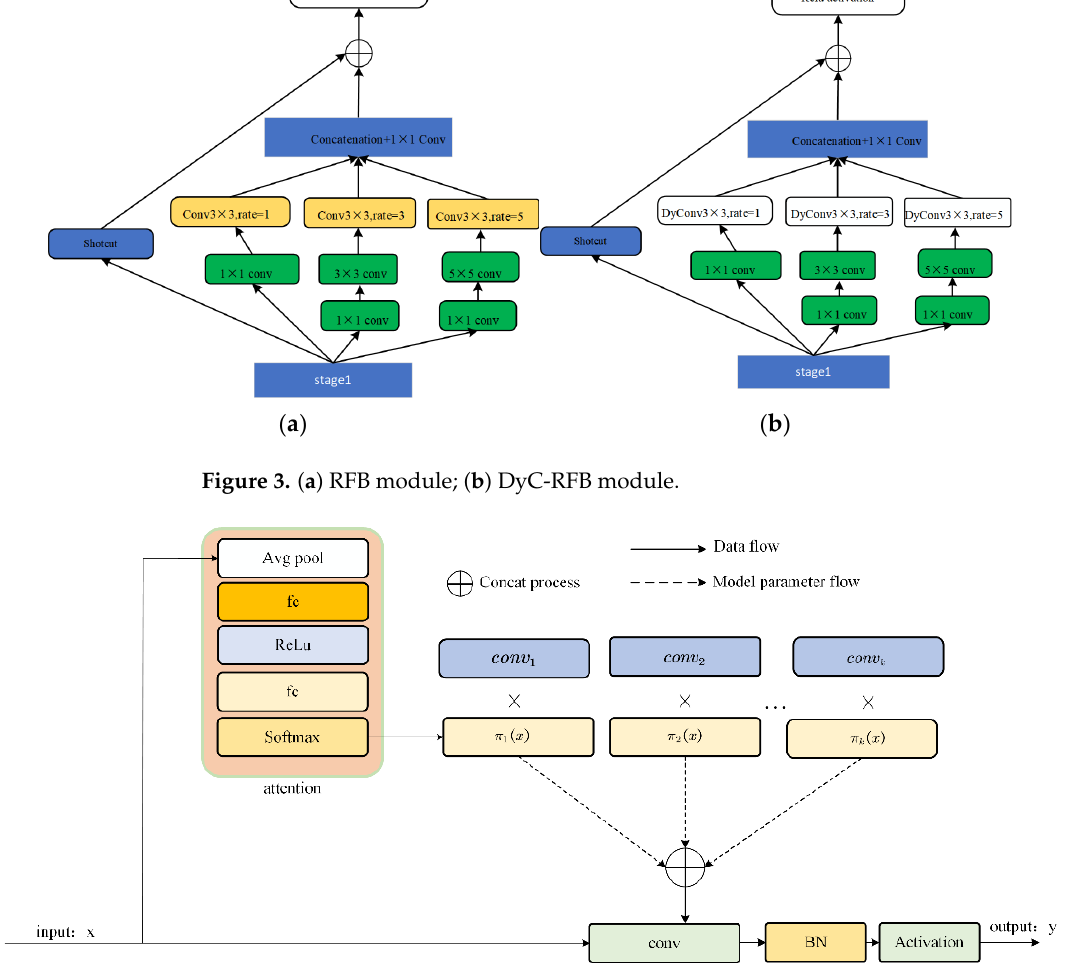
Figure 4. Dynamic convolution (DyConv) module.